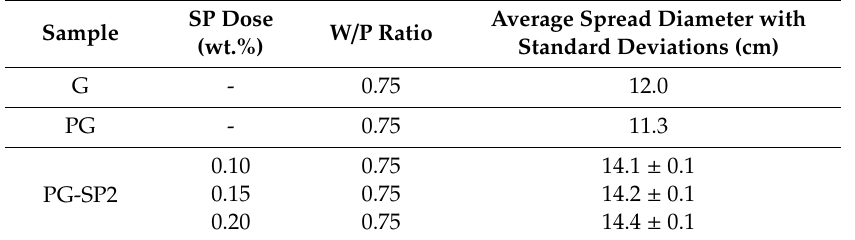
Table 2. Assortment of SP dose in photocatalytic gypsum plaster: the reduction of water content. SP Dose Sample (wt.%)